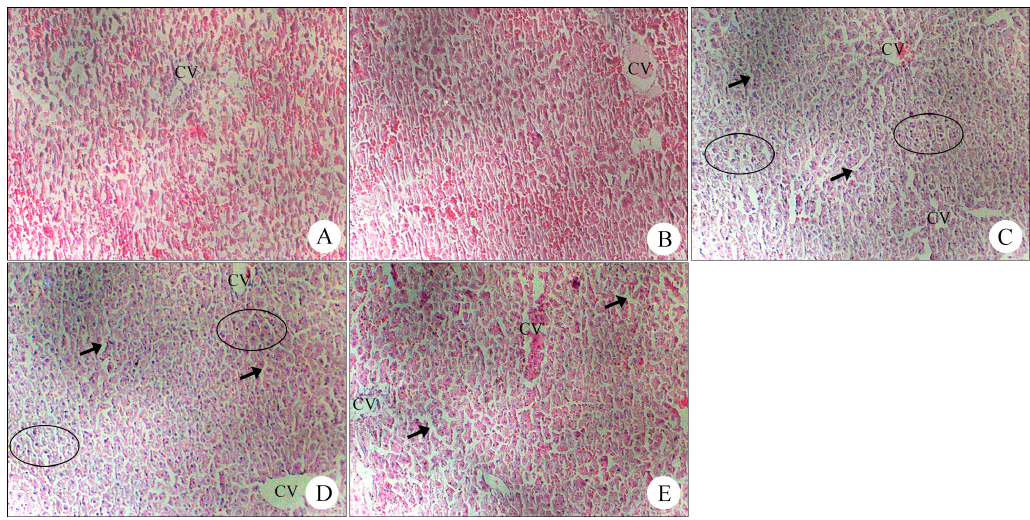
Figure 5. Histopathology of liver samples after treatment with different concentrations of volatile oil from Blumea balsamifera (BB oil) in normal rats. ( A ) Group A1: Control (the blank group) showed normal liver structure. ( B ) Group A2: Olive oil (vehicle) showed diffused vacuolar changes. ( C ) Group A3: BB oil (100% w/v) 1000 mg/kg showed diffused vacuolar changes; hepatocytes appeared pale with small discrete cytoplasmic vacuoles (arrow). Hepatocytes showed clear cytoplasm and pyknotic nuclei (circles), suggesting early mild hepatocellular necrosis. ( D ) Group A4: BB oil (50% w/v) 1000 mg/kg showed diffused vacuolar changes; hepatocytes appeared pale with small discrete cytoplasmic vacuoles or foamy cytoplasm (arrow); hepatocytes showed cytoplasm and pyknotic nuclei (circles). However, cytoplasmic vacuoles and pyknotic nuclei were significant less than in Group A3. ( E ) Group A5: BB oil (20% w/v) 1000 mg/kg showed diffused vacuolar changes; hepatocytes appeared pale with small discrete cytoplasmic vacuoles